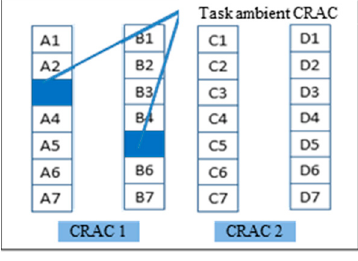
Figure 1. Floor plan of verification room. Table 1. Specifications of verification server room and computer room air conditioner